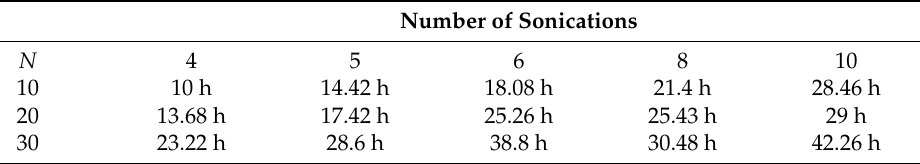
Table 5. Median of the execution time of the Matlab implementation running on a 16-core node com- puter measured over 15 runs as a function of the number of systems N and the number of sonications.